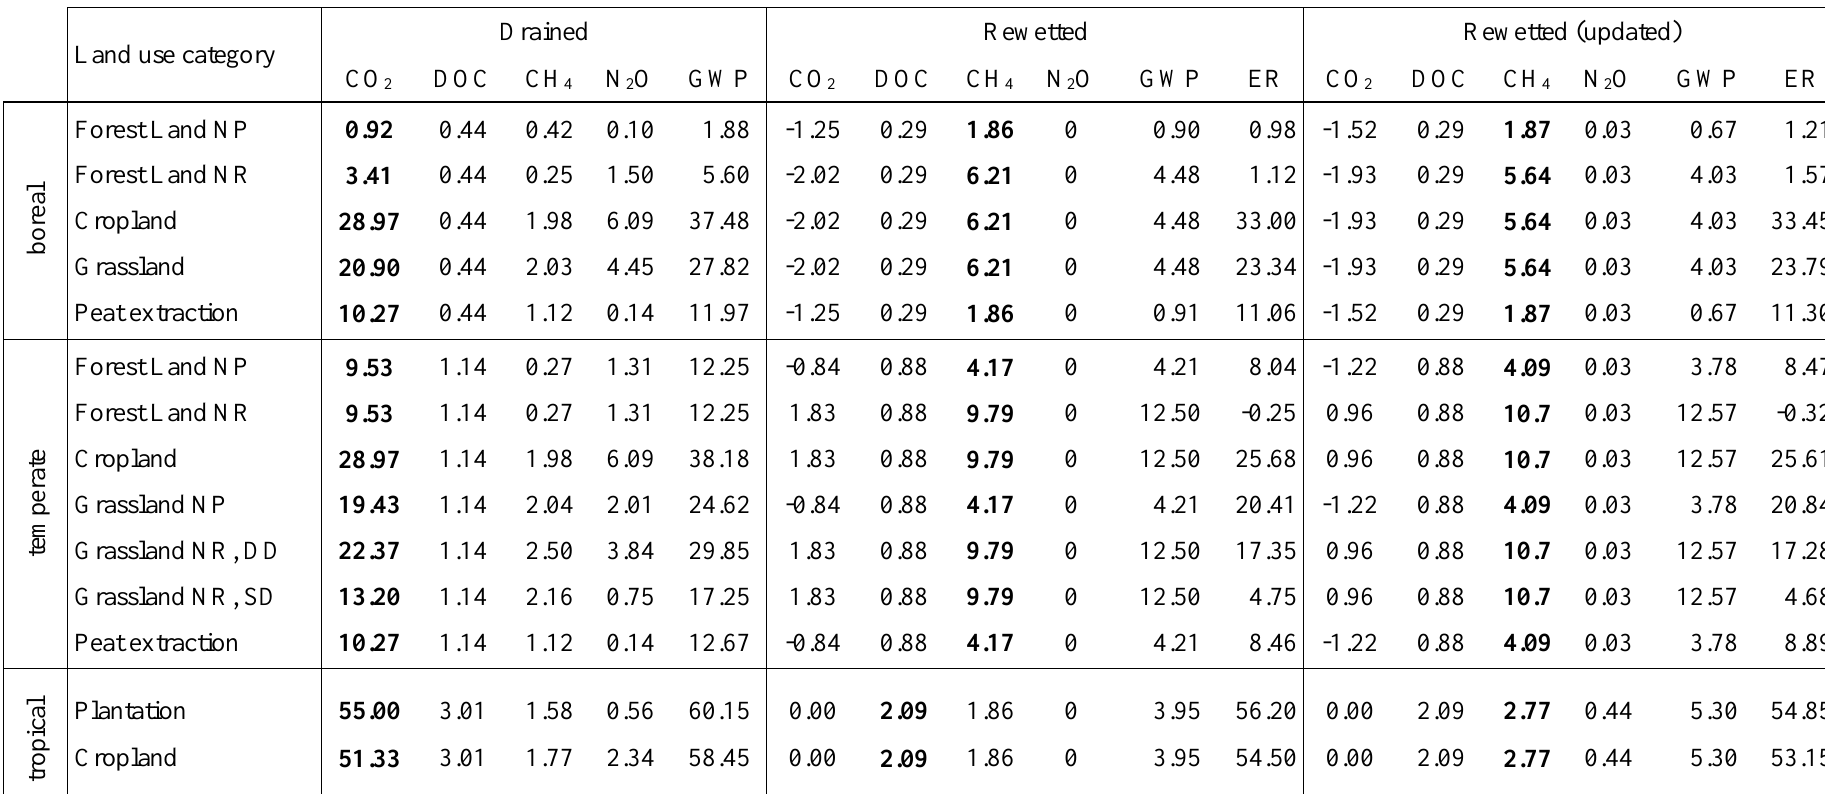
Table 5. Global warming potential (GWP) for drained and rewetted (presented here using the derived value from the Wetlands Supplement and an updated value that incorporates the new data published post 2013) organic soils for selected land use categories as defined by IPCC (2014a). Methane (CH 4 ) fluxes include emissions from ditches and were calculated using the default ditch area provided by IPCC (2014a). CH 4 and nitrous oxide (N 2 O) fluxes are converted to CO 2 eq. (t CO 2 -eq ha -1 yr -1 ) according to their GWPs on a 100-year timescale including climate–carbon feedbacks: CH 4 = 34 and N 2 O = 298 (Myhre et al. 2013). Positive values indicate a net warming effect on the climate and negative values indicate a net cooling effect. ER = emission reduction, NR = nutrient rich, NP = nutrient poor, DD = deeply drained, SD = shallow drained. Values in bold indicate the dominant GHG within each land use